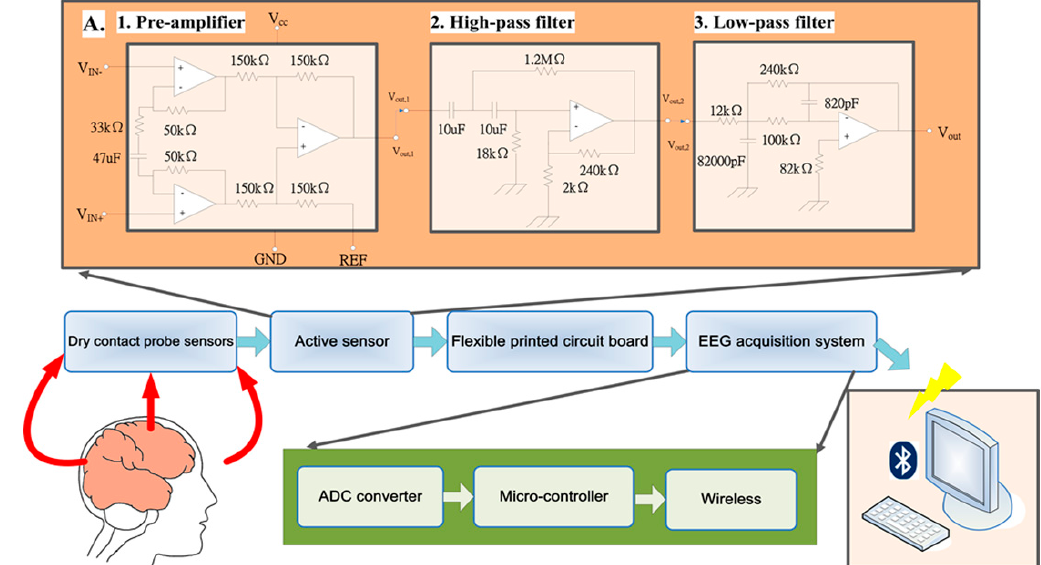
Figure 2. Overview of the hardware framework of the developed system. The electroencephalography (EEG) signals are measured by dry sensors, and the signals are then amplified and filtered by active circuit units. The amplified EEG signals are transmitted via cables to the EEG signal acquisition system, which digitizes the signals and transmits them to a personal computer.